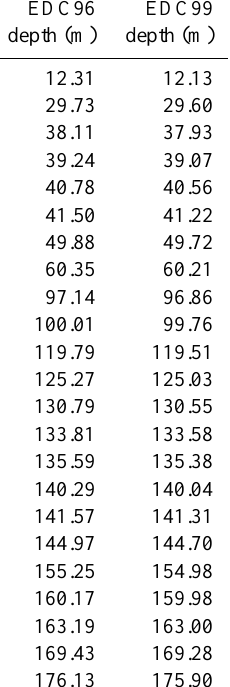
Fig. 3. Scheme of the different Vostok cores and shifts between them based on tephra recognition (black) and ECM synchronisation (green) (adapted from Basile, 1997).